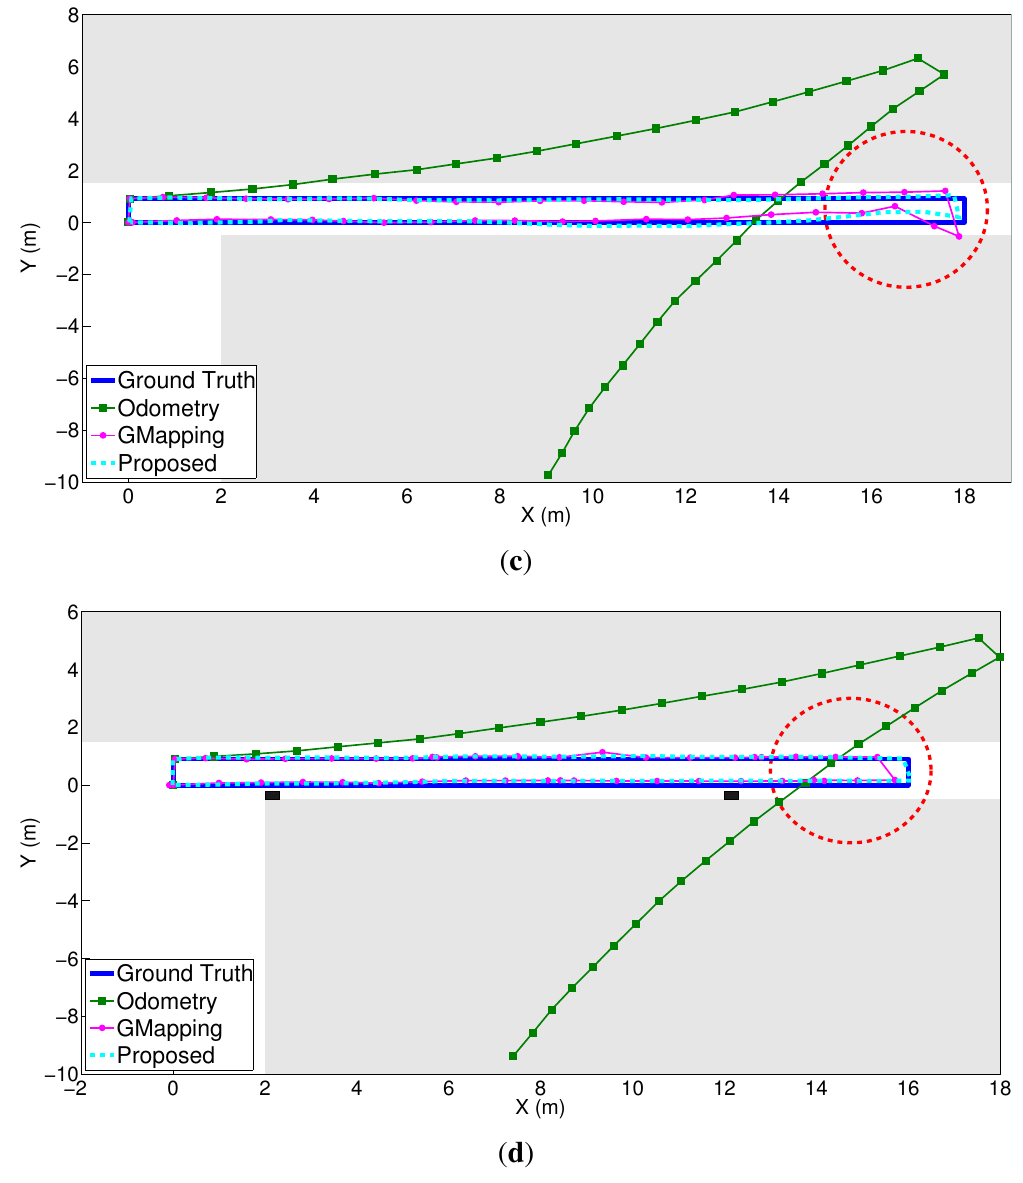
Figure 13. Experimental results comparing the odometry, GMapping and the proposed method. The trajectory of the proposed method is almost the same as the ground